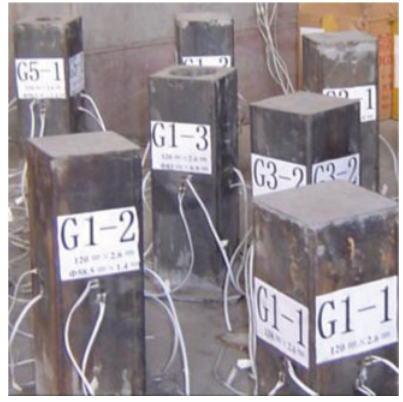
Fig. 2. Specimens after being